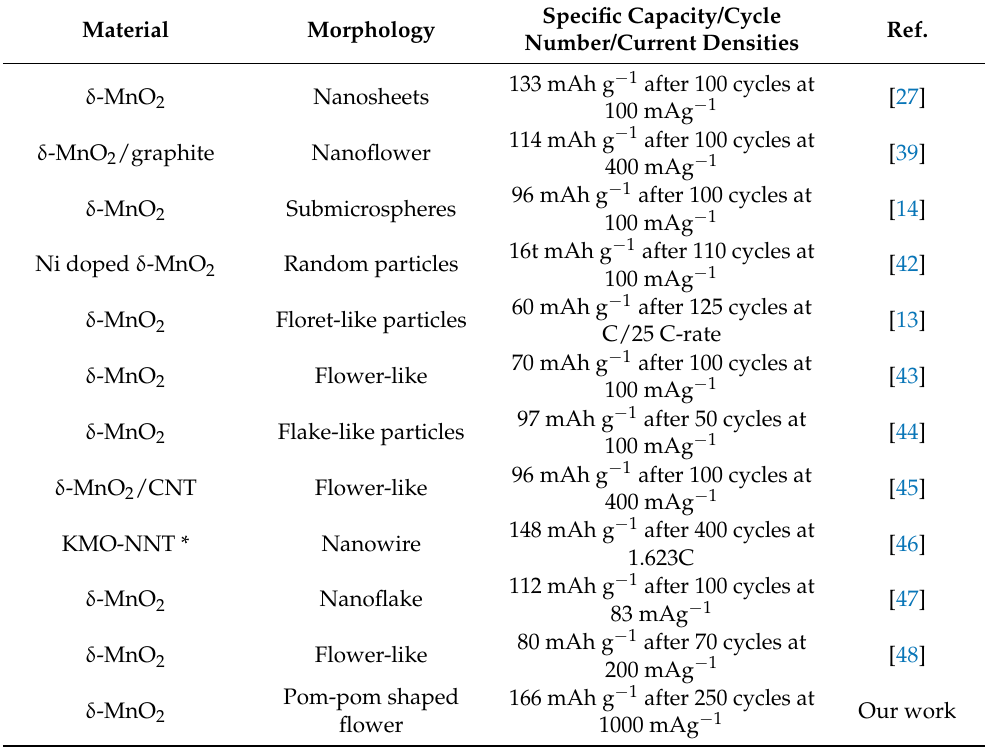
Table 1. A comparison between the specific capacities of the current pom-pom flower-like morphol- ogy of δ -MnO 2 electrode and previously reported δ -MnO 2 electrode based on various morphologies.